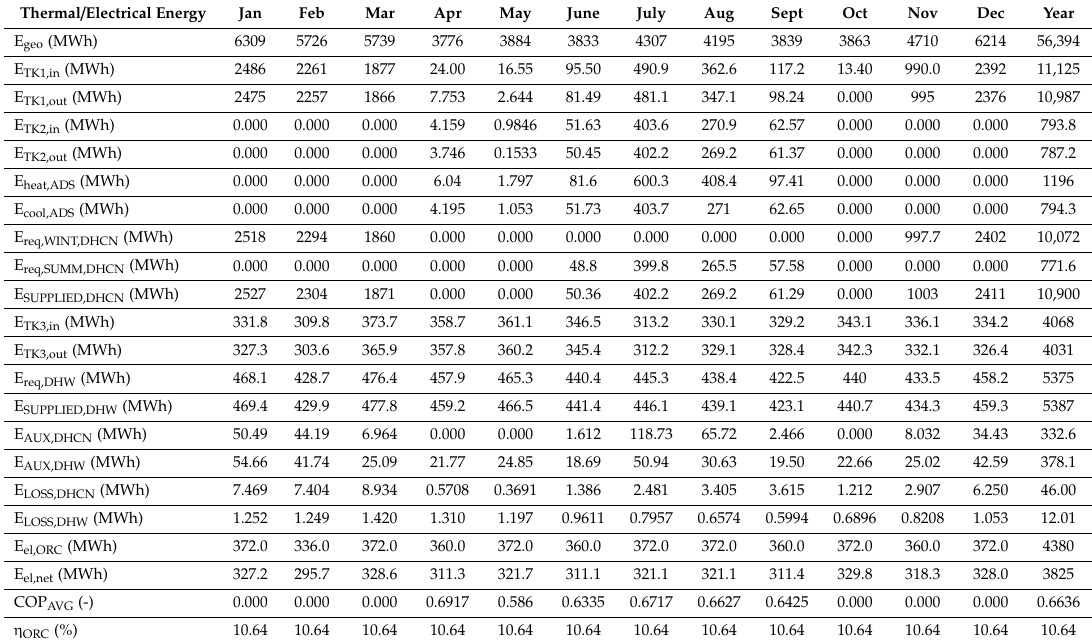
Table A6. Main results of the thermodynamic analysis (stop time of the DHCN at 22:00). Thermal / Electrical Energy